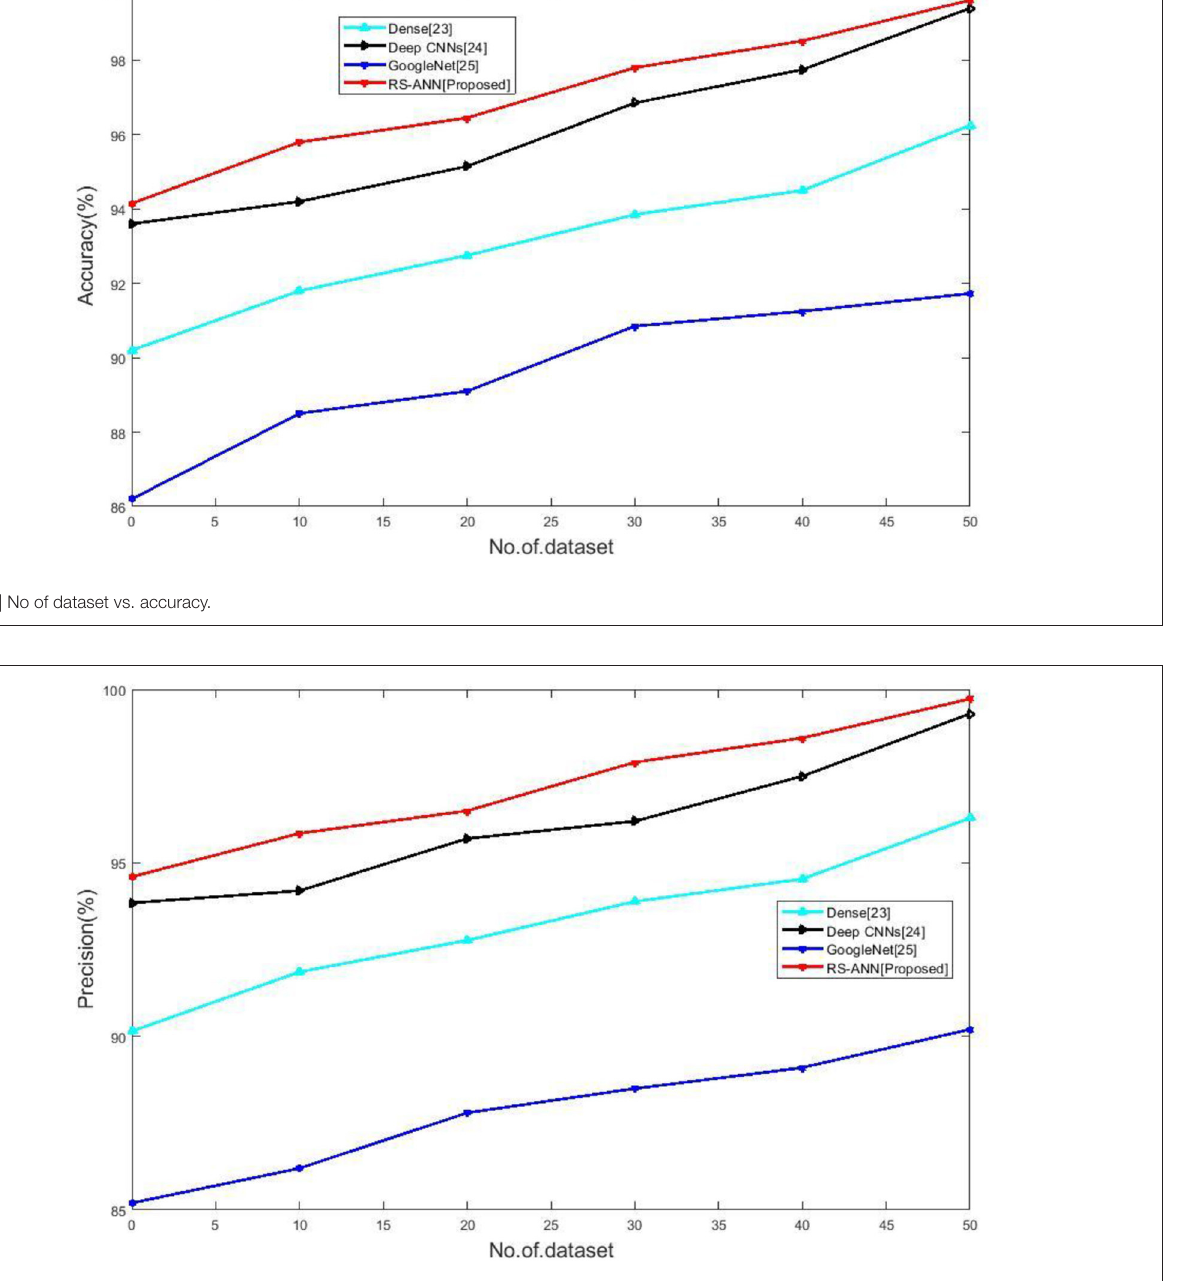
FIGURE 4 | No of dataset vs.